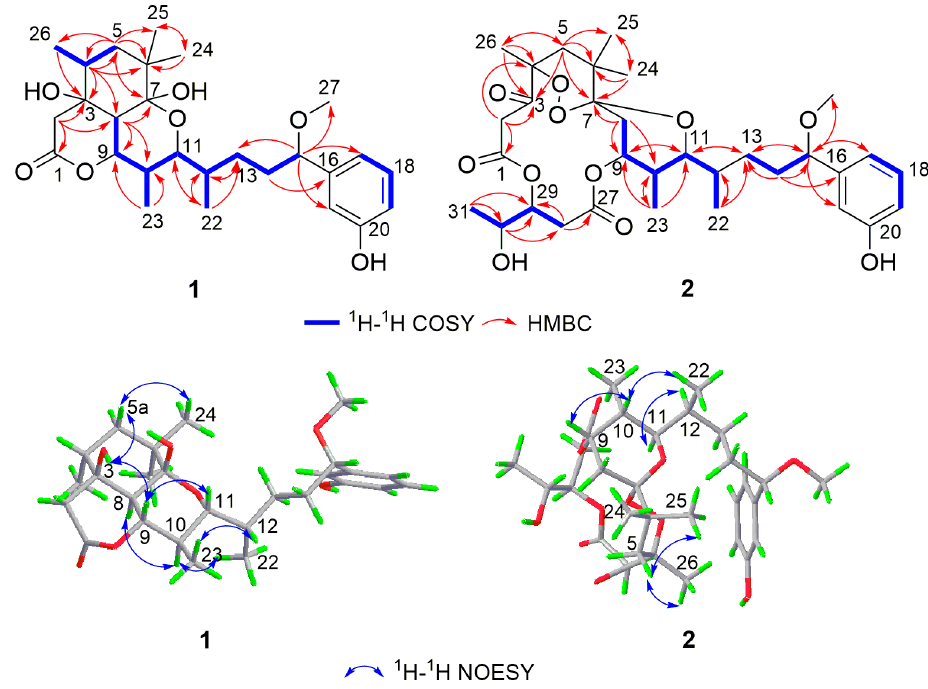
Figure 2. Key 2D correlations of 1 and 2 .